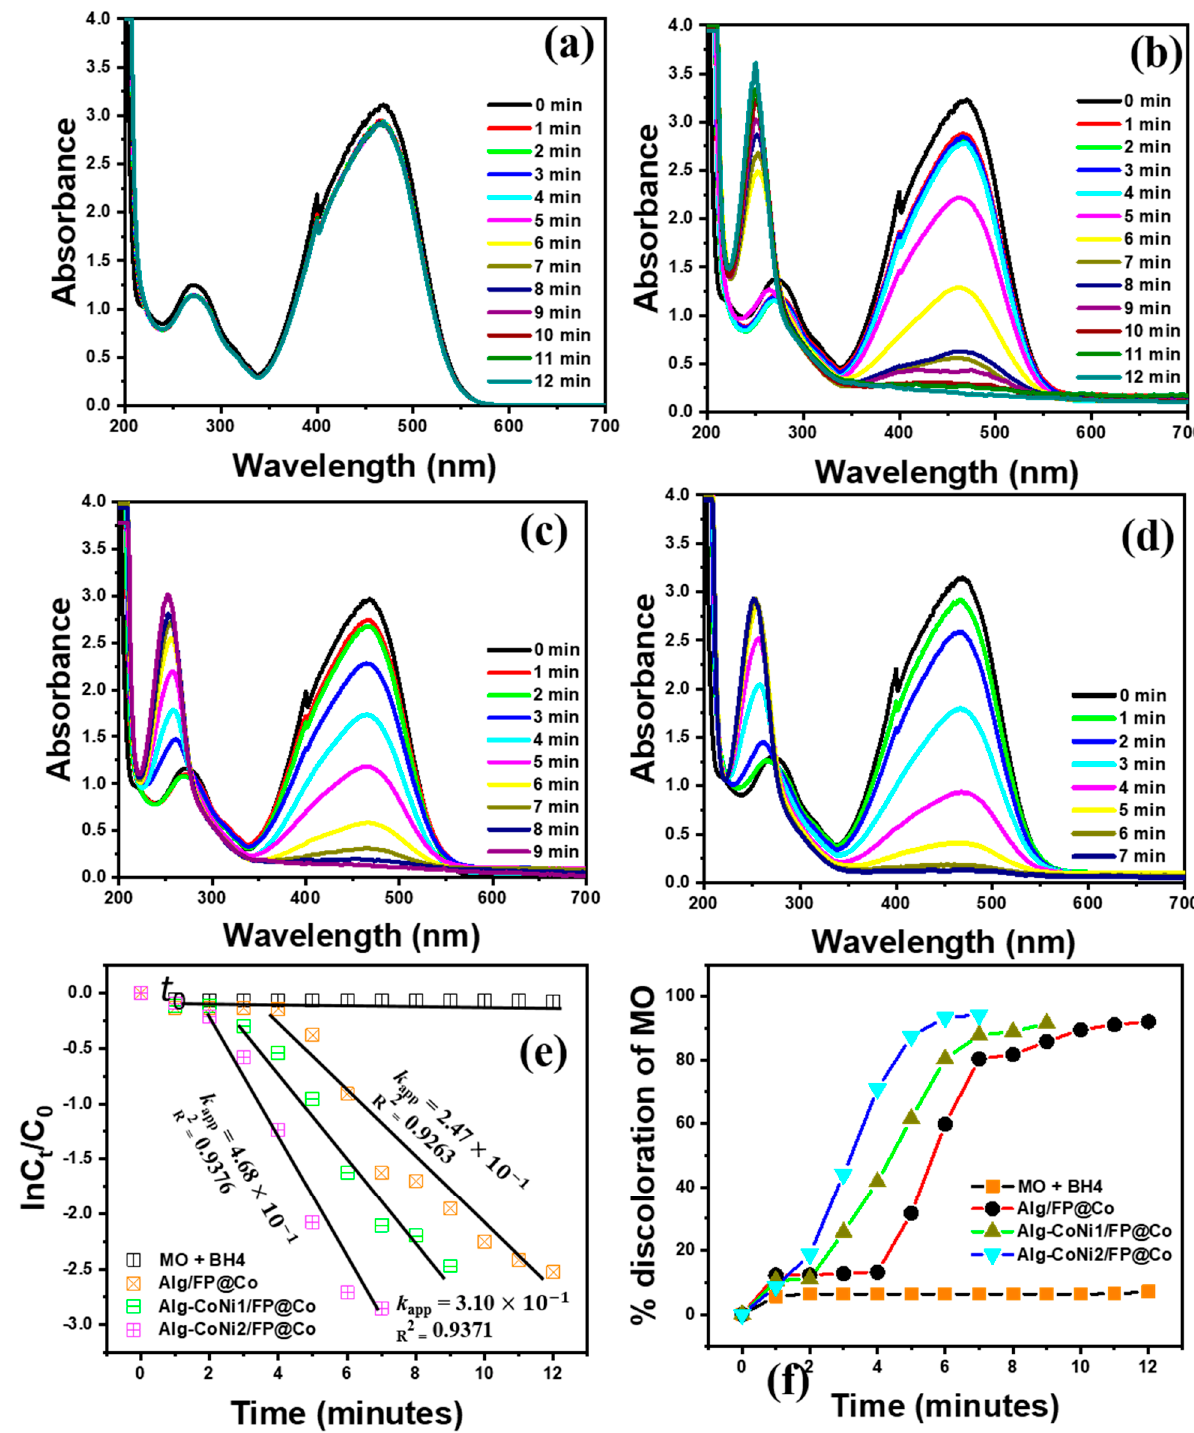
Figure 5. UV-Vis. absorbance spectra of MO dye discoloration in the presence of NaBH 4 ( a ), and Alg/FP@Co ( b ), Alg- CoNi1/FP@Co ( c ), and Alg-CoNi2/FP@Co NPs ( d ), linear relationship of pseudo-1st order kinetics ( e ), and percent degradation of the MO dye ( f ).